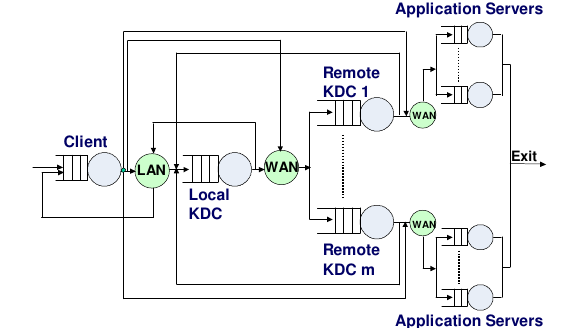
Figure 4. A Queueing Network with n Application Servers for